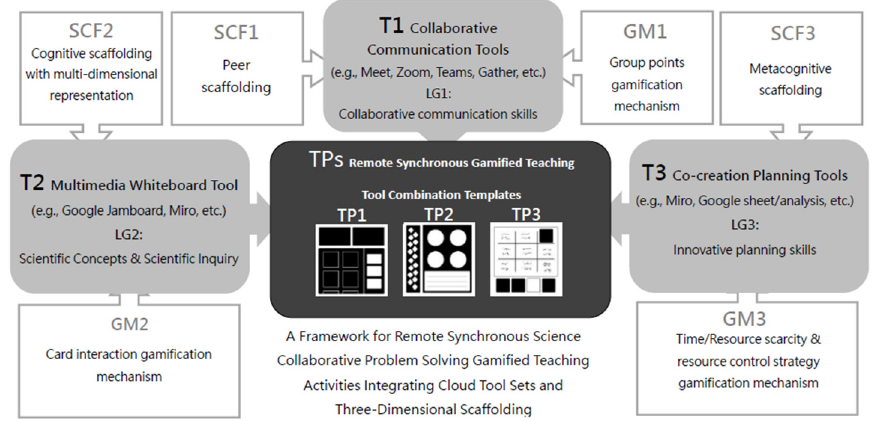
Figure 1. A Framework for Remote Synchronous Science Collaborative Problem Solving Gamified Teaching Activities Integrating Cloud Tool Sets and Three-Dimensional Scaffolding.